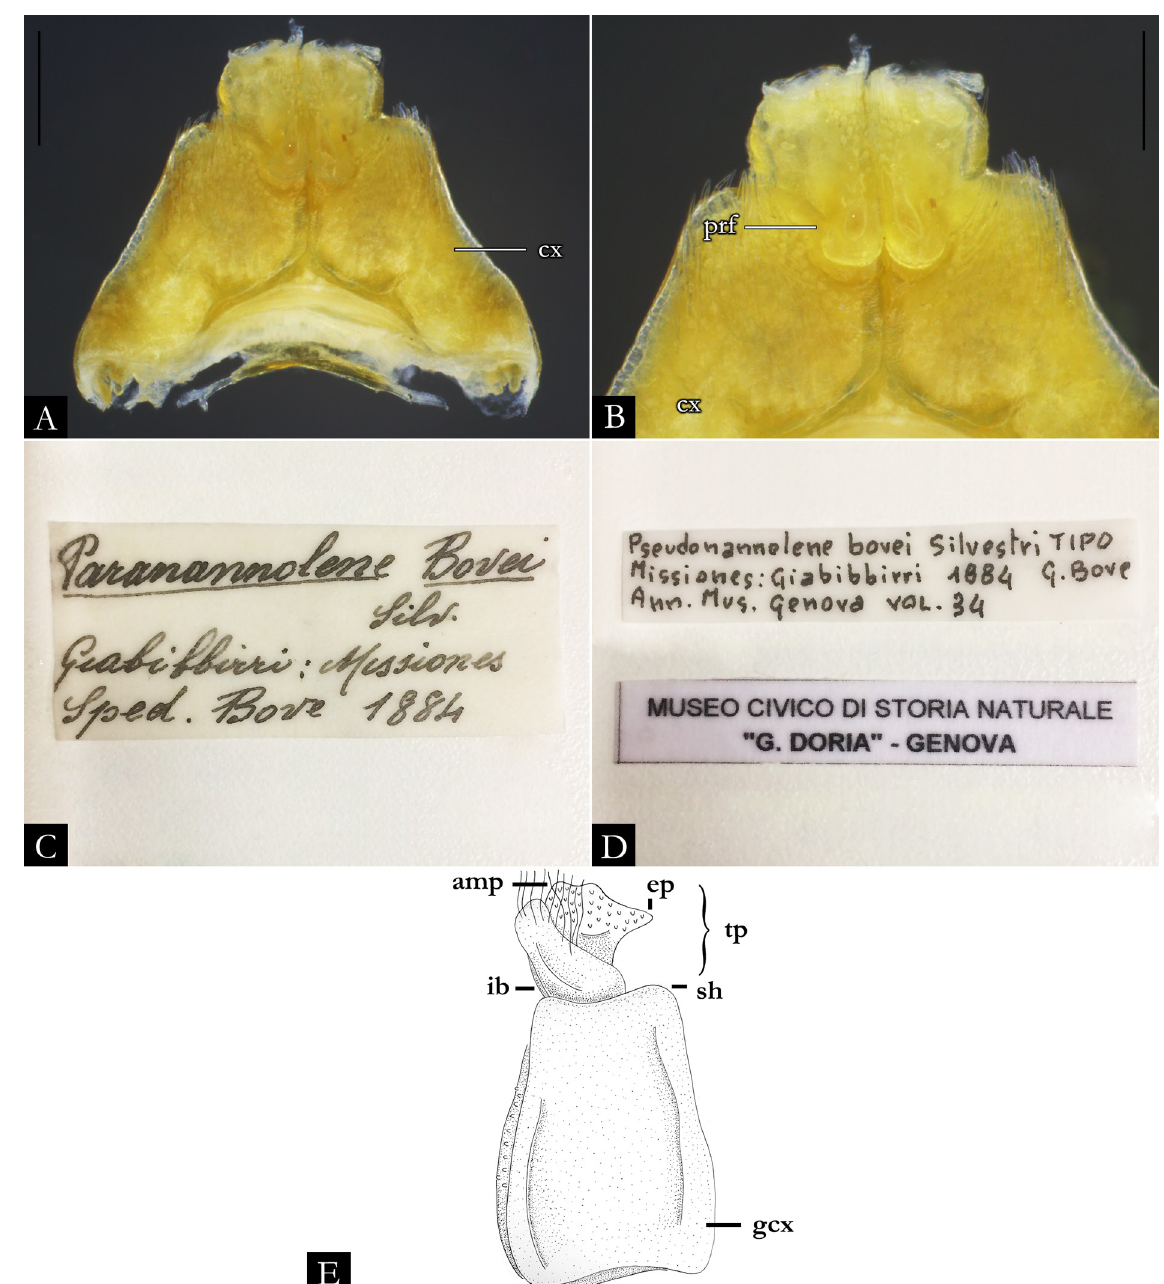
Fig. 52. Pseudonannolene bovei Silvestri, 1895, syntype, ♂ (MCSN). A . First leg-pair. B . Detail of prefemur. C–D . Original label of type material. E . Schematic drawing of left gonopod in anal view (modified from Silvestri 1895a: fig. 9). Abbreviations: see Material and methods. Scale bars = 0.2